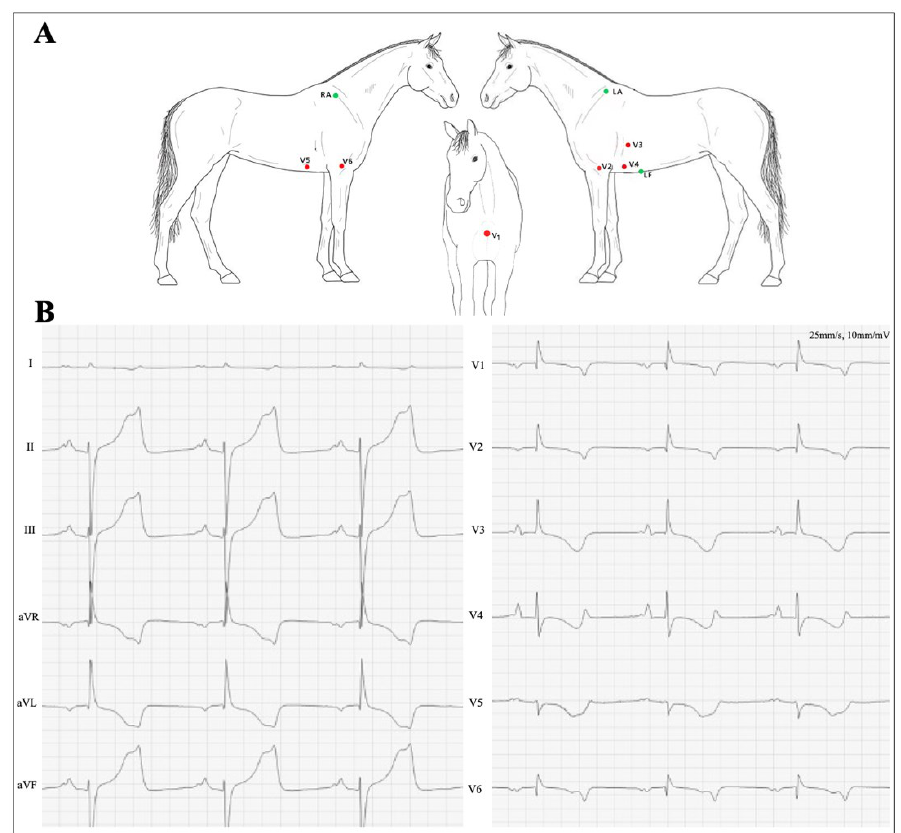
Figure 2. A : Copenhagen Method electrode placement, figure reprinted with permission from Hes- Figure 2. ( A ) Copenhagen Method electrode placement, figure reprinted with permission from selkilde et al 2020 JVIM [6]. B : All leads seen two minutes after the second occlusion. Hesselkilde et al 2020 JVIM [6]. ( B ) All leads seen two minutes after the second occlusion. LA: left arm, RA: right arm, LF: left foot, I: Lead I, II: Lead II, III: Lead III, Augmented vector right: aVR, Augmented vector left: aVL, Augmented vector foot: aVF. Precordial leads: